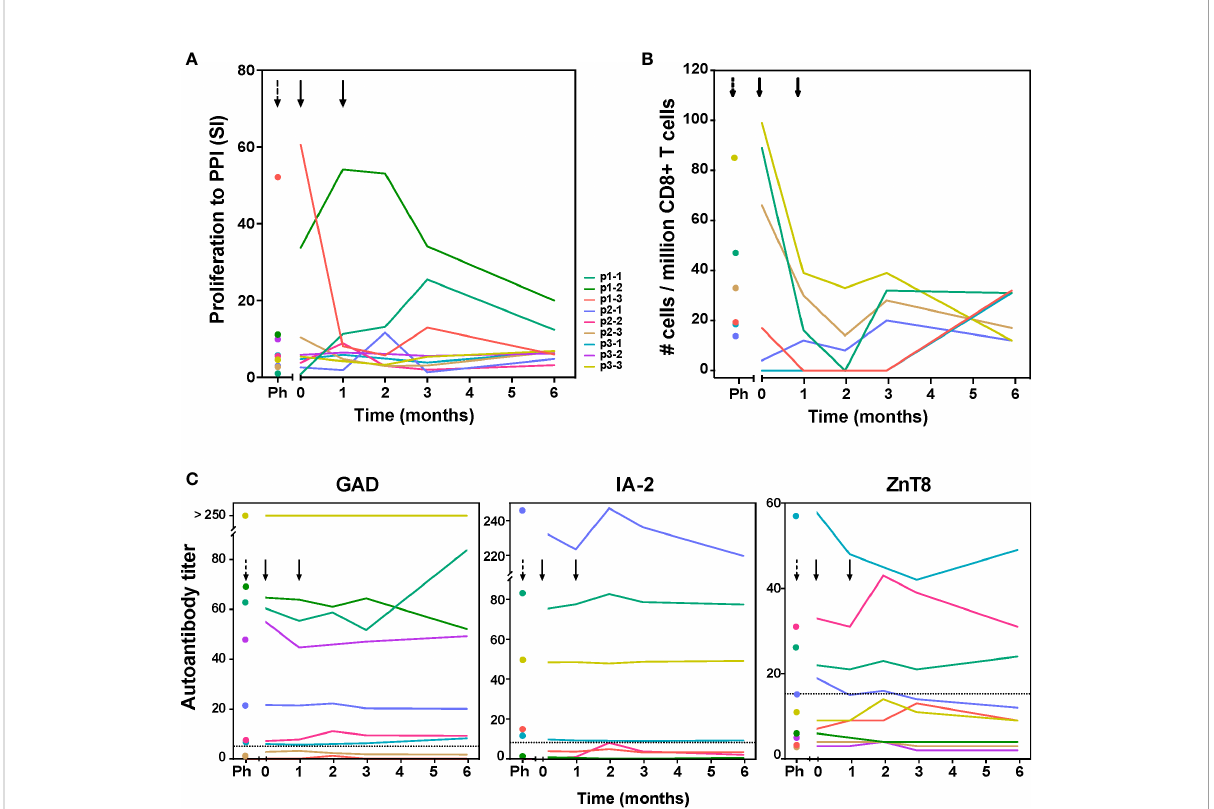
FIGURE 2 Immunity to preproinsulin (PPI) and autoantibody titers up to 6 months after tolDC therapy. (A) Proliferative responses of T-cells reactive with preproinsulin are depicted prior to leukapheresis ( fi rst time point), before tolDC (0) and at different time points after tolDC therapy for individual patients. (B) Quanti fi cation of PPI9-24-speci fi c CD8 + T-cells using Q-dot assay prior to leukapheresis (Ph), before tolDC (0) and at different time points after tolDC therapy in six HLA-A2 + patients. In three patients with the highest PPI-speci fi c T-cell counts prior to therapy, reduction after tolDC therapy was observed, while low numbers of PPI-speci fi c CD8 + T-cells pre-treatment, remained low. (C) Autoantibody titers (GAD65, IA- 2 and ZnT8) after tolDC treatment, show no changes i.e. signs of induction/increase in beta – cell autoimmunity. Lines represent individual patient titers. Values in the gray area are below the negative cut-off for that speci fi c autoantibody. Titers too low to show in the graphs: for p1-3 GAD ≤ 1.2; for p1-2 IA-2 ≤ 0.8, for p2-3 and p3-2 IA-2 =